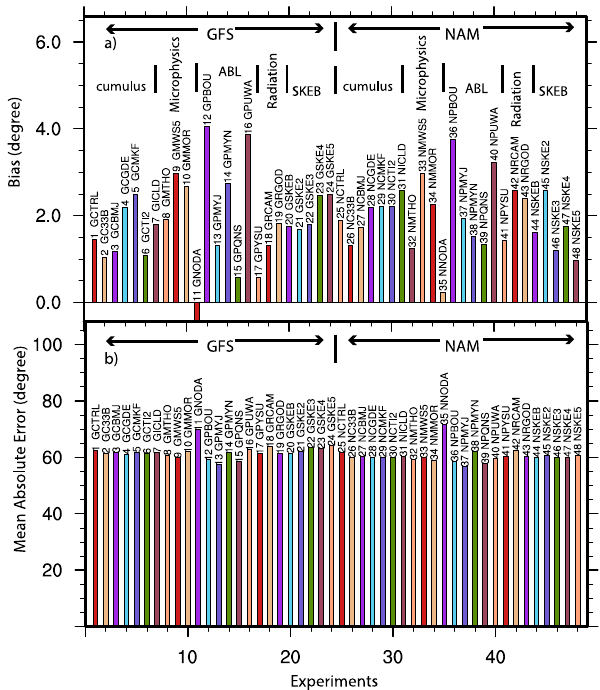
Figure 10. Averages on Domain 3 of ( a ) bias and ( b ) MAE in wind direction at 10 m (WD10) from analyses during the one-week study period in January. The unit is degrees.